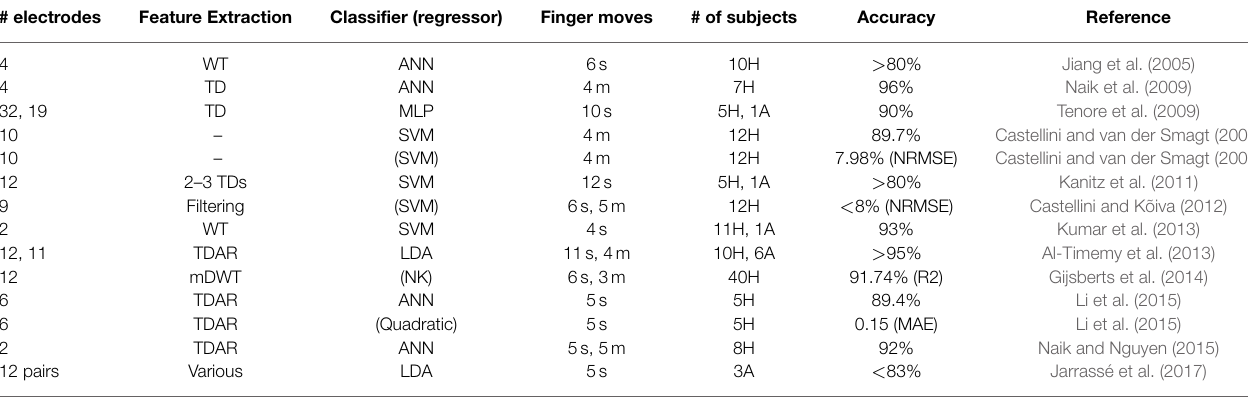
TABLE 1 | A table of related work found in the literature for both finger movement classification and force